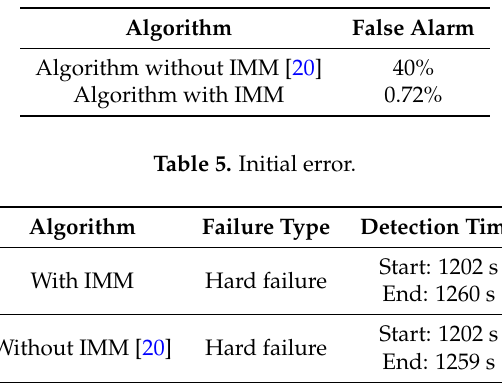
Table 4. False alarm of the two algorithms.